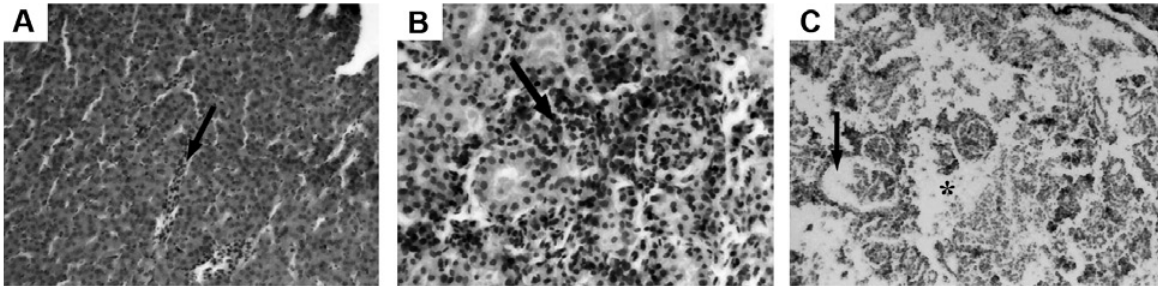
Figure 3 - a. Liver of Coridora in concentration of 50 mg.L -1 of formaldehyde present congestion (arrow). HE 400x. b. Kidney of coridora exposed at concentration of 50 mg.L -1 of formaldehyde present congestion (arrows). HE 400x. c. Kidney of coridora in concentration of 100 mg.L -1 formaldehyde showing necrosis (*) and increased Bowman's space (arrow). HE